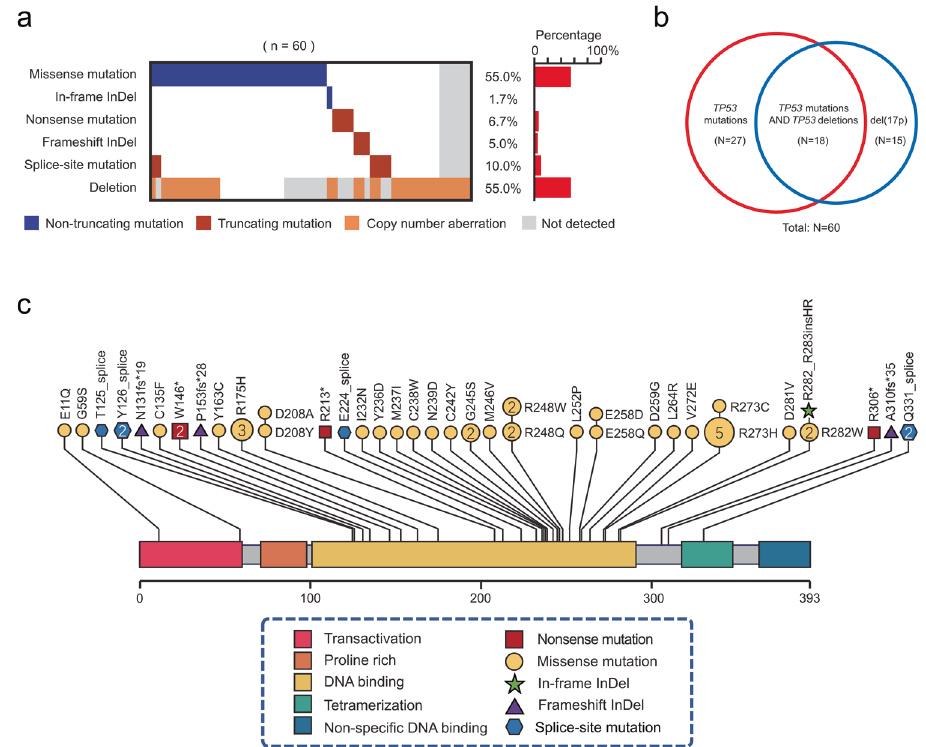
Fig. 1 Mutational pro fi le of TP53 alterations. a Heatmap showing individual non-synonymous somatic mutations found in individuals administered CAR-T cell infusion ( n = 60). Each row represents one type of TP53 alterations, and each column represents a patient with R/R B-NHL. The horizonal bar graph shows gene mutation frequencies. b Venn diagram demonstrates different TP53 alterations identi fi ed in 60 cases. Totally 42 (70.0%) individuals harbored TP53 mutation(s) or sole del(17p), with 27 (45.0%) and 15 (25.0%) showing TP53 mutation(s) and deletions, respectively. The remaining 18 (30.0%) cases had biallelic TP53 aberrations ( TP53 mutation and del(17p) in the fi rst and second alleles, respectively). c TP53 mutations are plotted above the protein divided into the main domains. Among the 51 mutations identi fi ed, 37 were missense mutations (yellow), 6 were splice-site mutations (blue), 4 were nonsense mutations (red), 3 were frameshift insertions or deletions (indels; purple), and 1 was a non-frameshift indel (green). Recurrent mutations were identi fi ed in 3 codons, including R273 ( n = 6), R248 ( n = 4) and R175 ( n = 3). The x -axis indicates the amino acid